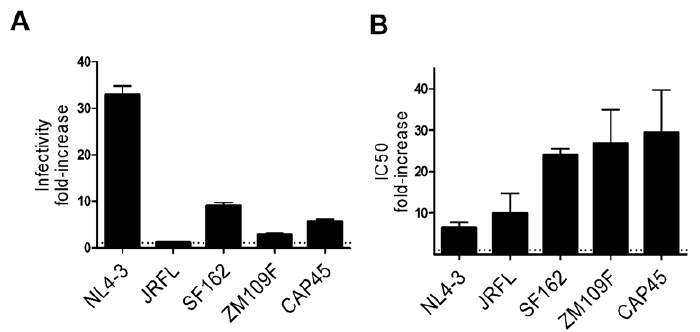
Figure 4. The effect of Nef on neutralization does not depend on the effect of Nef on infectivity. A, fold-increase of infectivity caused by Nef on HIV-1 NL4-3 pesudotyped with Env glycoproteins derived from the indicated HIV-1 isolates, measured on TZM-bl reporter cells. B, fold-increase of 4E10 IC50 for the same viral pseudotypes, derived from the experiments shown in Figure 3, obtained by dividing the IC50 of the Nef-positive virus with that of the Nef-defective virus.